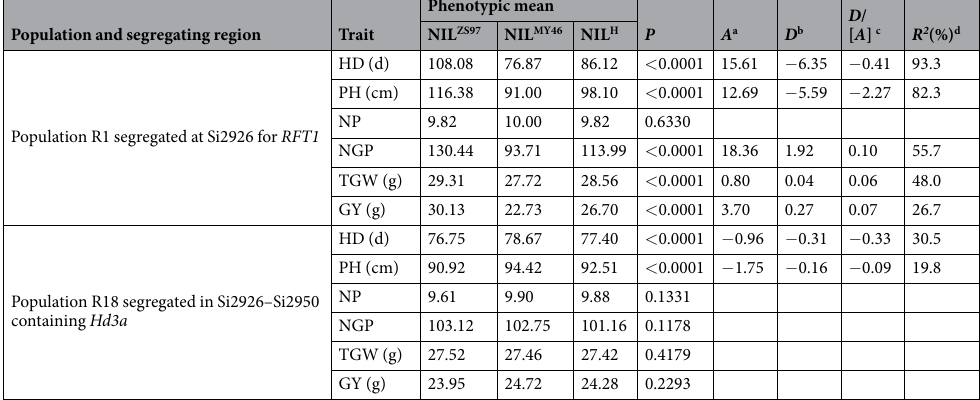
Table 2. QTL analysis using two NIL-F 2:3 populations. NIL ZS and NIL MY are near isogenic lines carrying homozygous alleles from ZS97 and MY46, respectively. NIL H are segregating lines derived from the ZS97/MY46 heterozygote. Each population consisted of 30 NIL ZS lines, 60 NIL H lines, and 30 NIL MY lines. They were grown in Hangzhou in 2010 using a randomized complete block design with two replications. HD, heading date. PH, plant height. NP, number of panicles per plant. NGP, number of grains per panicle. TGW, 1000-grain weight. GY, grain yield per plant. a A , additive effect of replacing a MY46 allele with a ZS97 allele. b D , dominance effect. c D /[ A ], degree of dominance. d R 2 , proportion of phenotypic variance explained by the QTL effect.